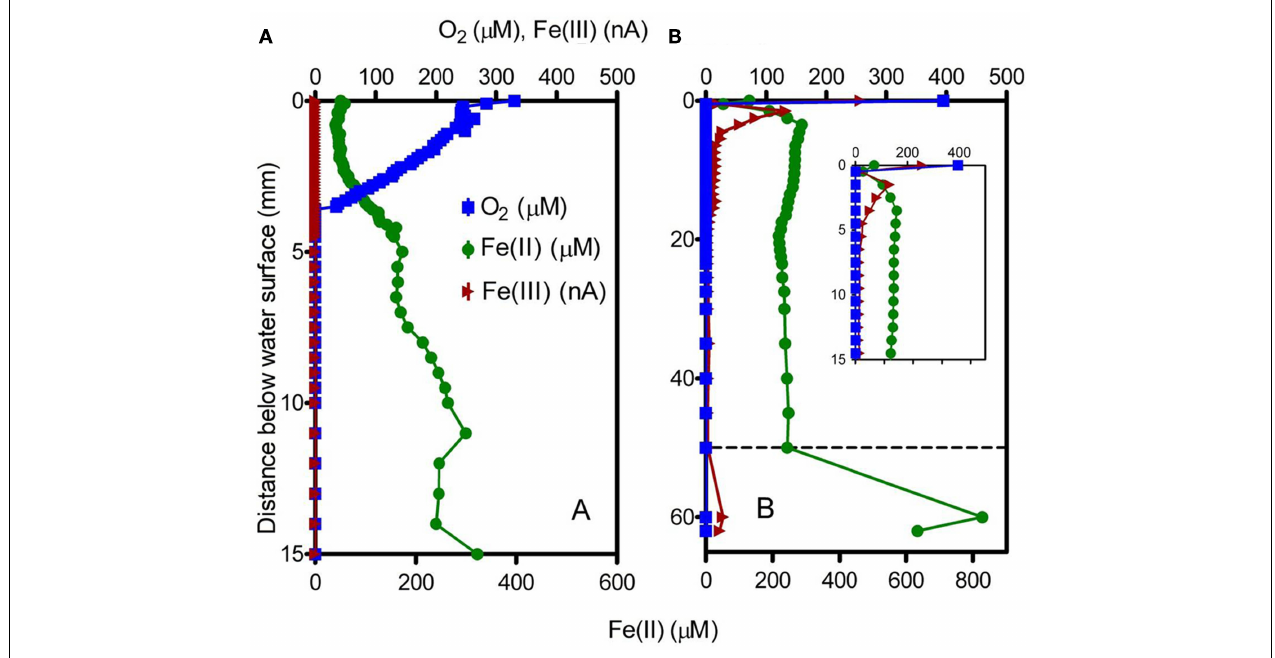
FIGURE 4 |Voltammetric microelectrode profiles for the microbial mat (A) and the puffball structure (B). Dashed line in (B) indicates the approximate surface of the flocculant puffball structure; inset shows an expanded scale of the first